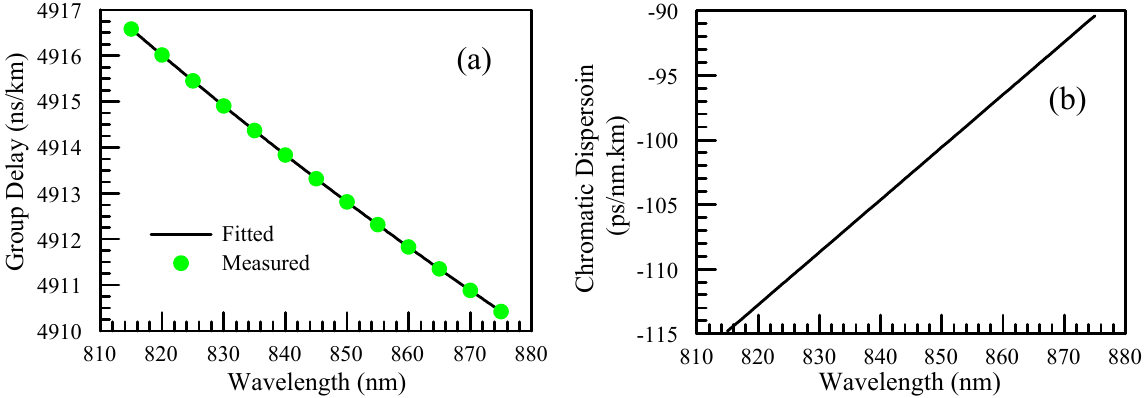
Figure 3. ( a ) The group delay vs. wavelength for a Hi780 fiber. ( b ) The chromatic dispersion vs. wavelength for a Hi780 fiber.